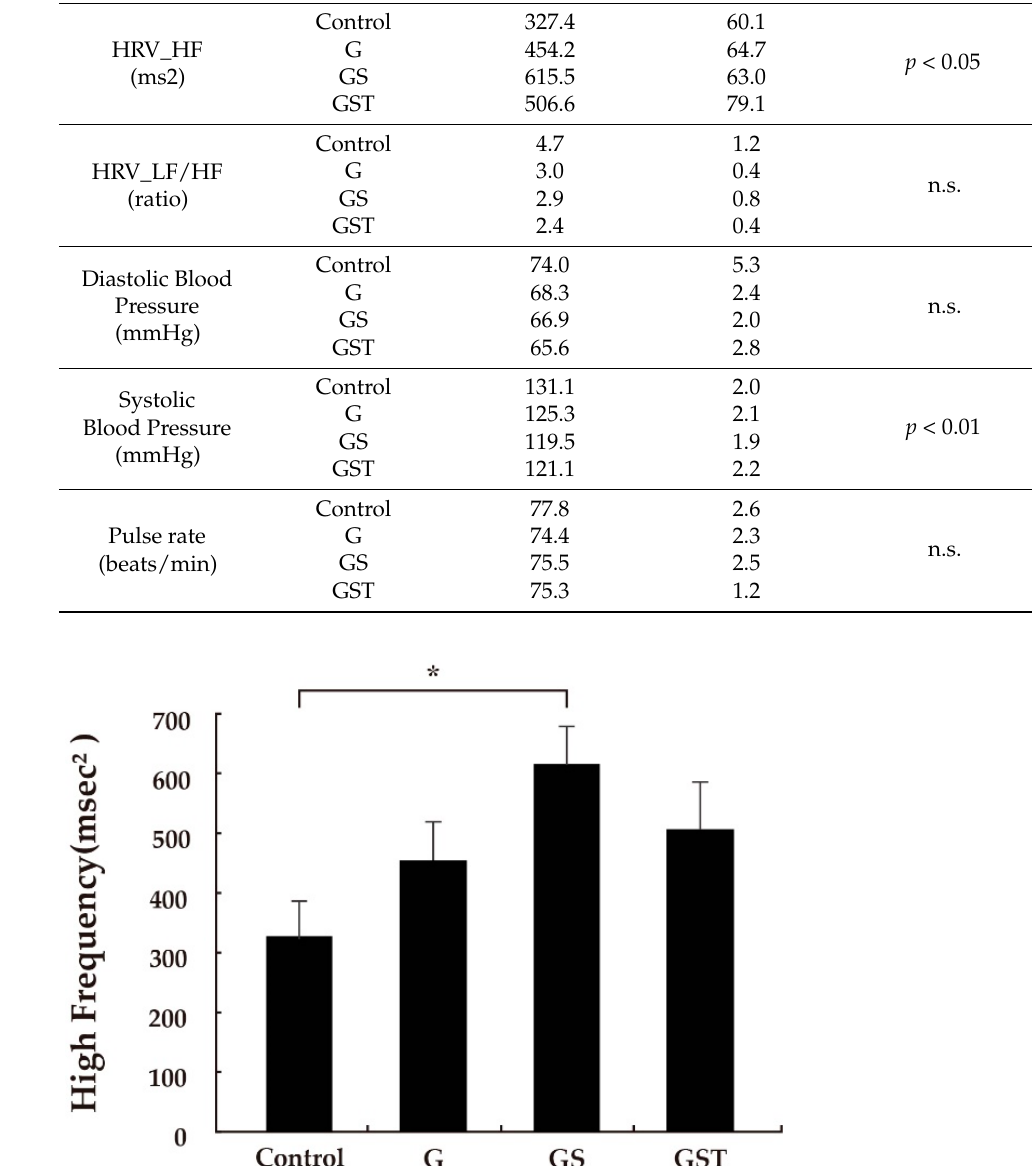
Figure 3. Values of systolic blood pressure after viewing the four rooftop images. Control: no vegetation with concrete floor; type G: grass vegetation; type GS: grass-shrubs vegetation; type GST: grass-shrubs-trees vegetation; n = 15, mean ± SE; **, p < 0.01. An analysis of the psychological responses to the four images using SD methods showed some significant differences in the visual perception of the vegetation designs. Significantly higher scores for naturalness, attractiveness, and comfort were found in response to the GS and GST images compared to the control (Figure 4). Despite a higher mean value of type G than the control, no significant difference was detected in any SD subscale. An analysis of the POMS data supported the premise that rooftop vegetation could change viewers’ mood states in a positive way and that mood state could differ according to the vegetation design (Figure 5). The scores of negative subscales, such as